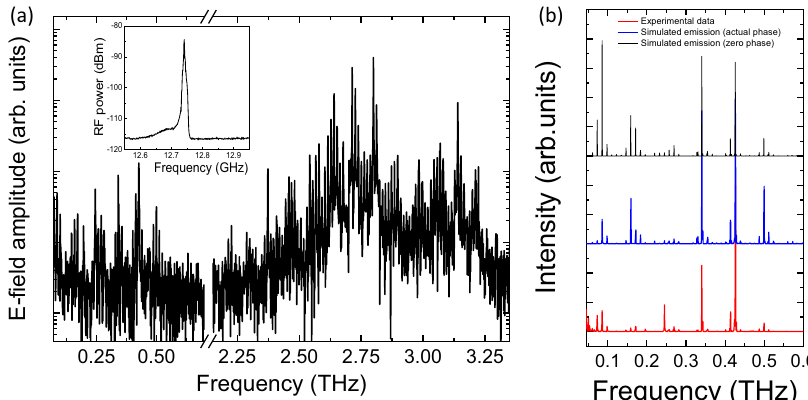
Fig. 4 mmWave generation from broadband QCL (QCL 2 ). a Full amplitude spectrum showing THz emission centred at 2.8 THz with a bandwidth of 800 GHz and nonlinear mmWave generation up to 500 GHz. Inset - fundamental electrical beatnote from THz QCL detected using the QCL as a detector and a spectrum analyser. b Enhanced view of mmWave intensity spectrum (red) compared to simulated emission for THz spectrum with measured phases (blue) and assuming equal phases (black). Spectra offset for clarity. The QCL is driven in pulsed mode (10% duty cycle) and at a fi xed heat sink temperature of 10